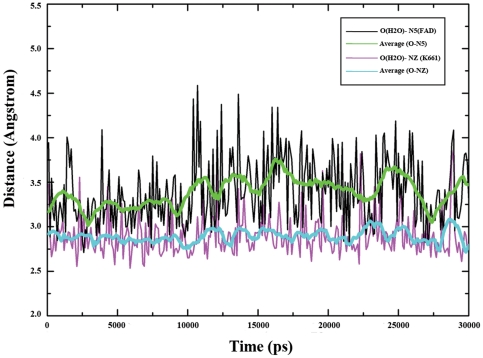
Distance evolution along simulation time for the two hydrogen bonds in the lysine-water-flavin motif.The red curve and blue curve were obtained by 5 ps averaged.